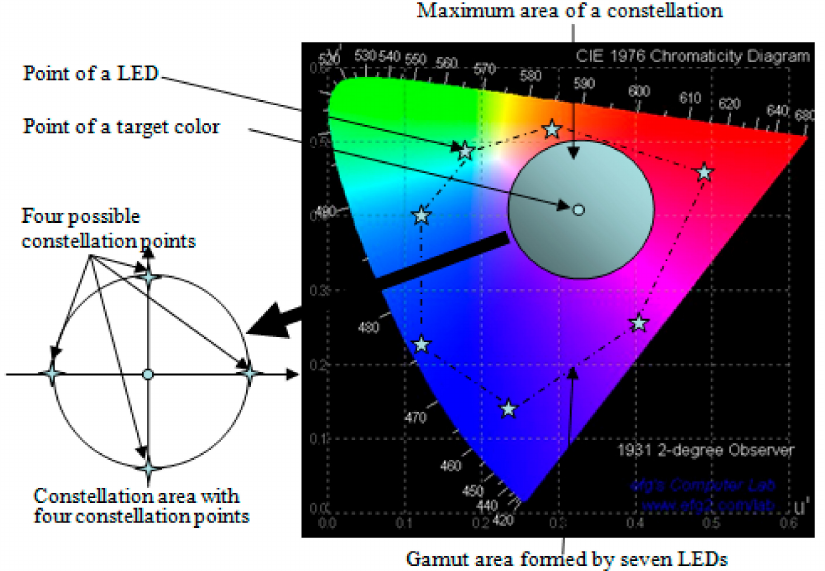
Figure 3. Generation of a constellation diagram in Color Space CIE L*u*v* (CIELUV) color space